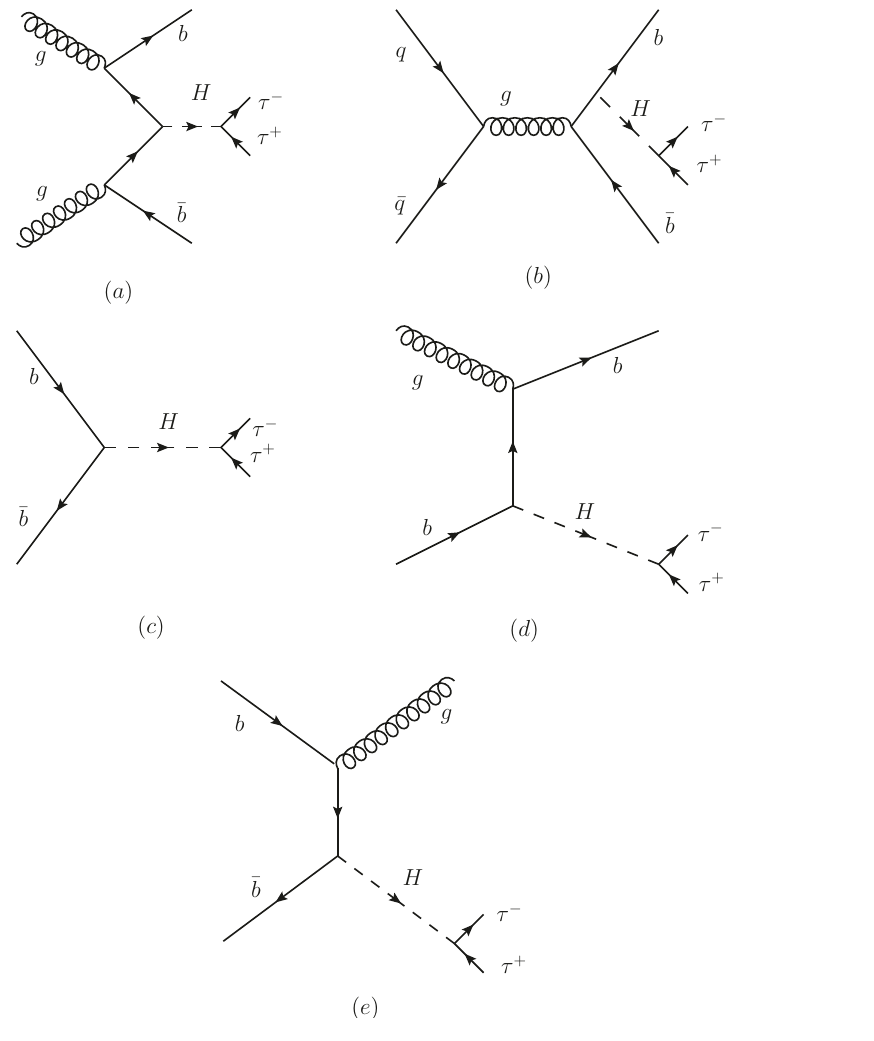
Figure 35 . The Feynman diagrams for 4F (a) gg b (cid:22) b H (LO), (d) gb !